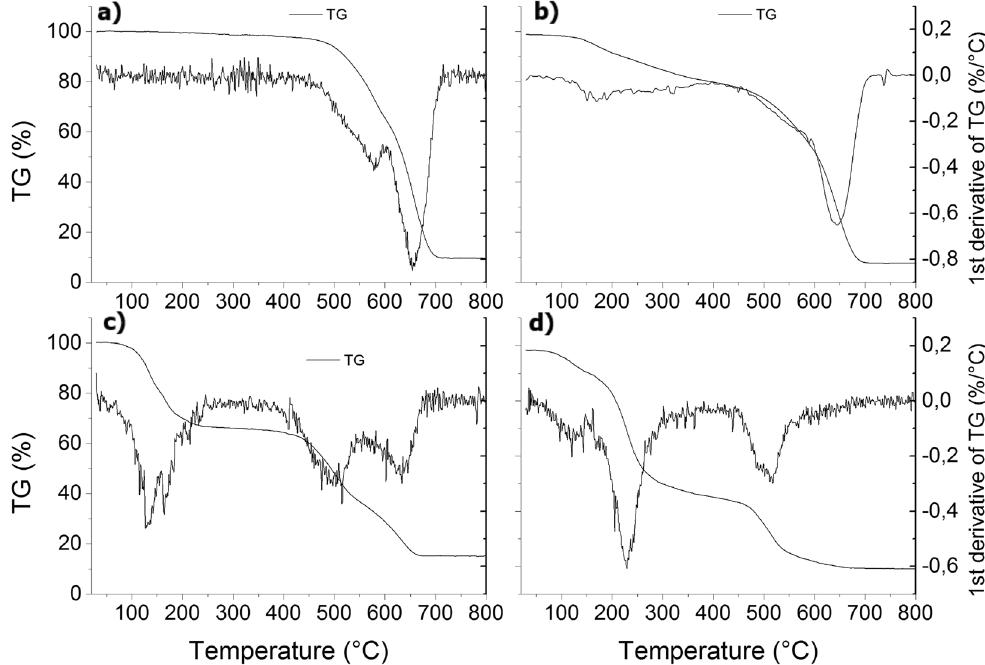
Figure 4. TGA curves for CNT wires: ( a ) after annealing at 400 °C; ( b ) after purification and H 2 O 2 treatment; ( c ) after purification, pre-treatment with H 2 O 2 and HClO 4 treatment; ( d ) after purification, pre-treatment with H 2 O 2 and H 2 SO 4